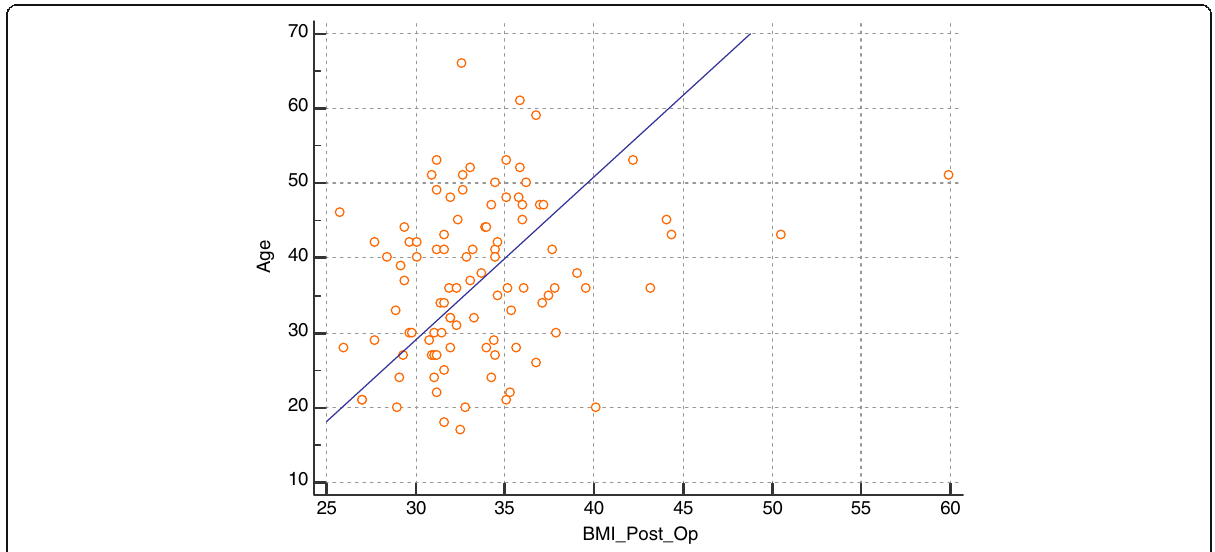
Fig. 1 Correlation between postoperative BMI and age